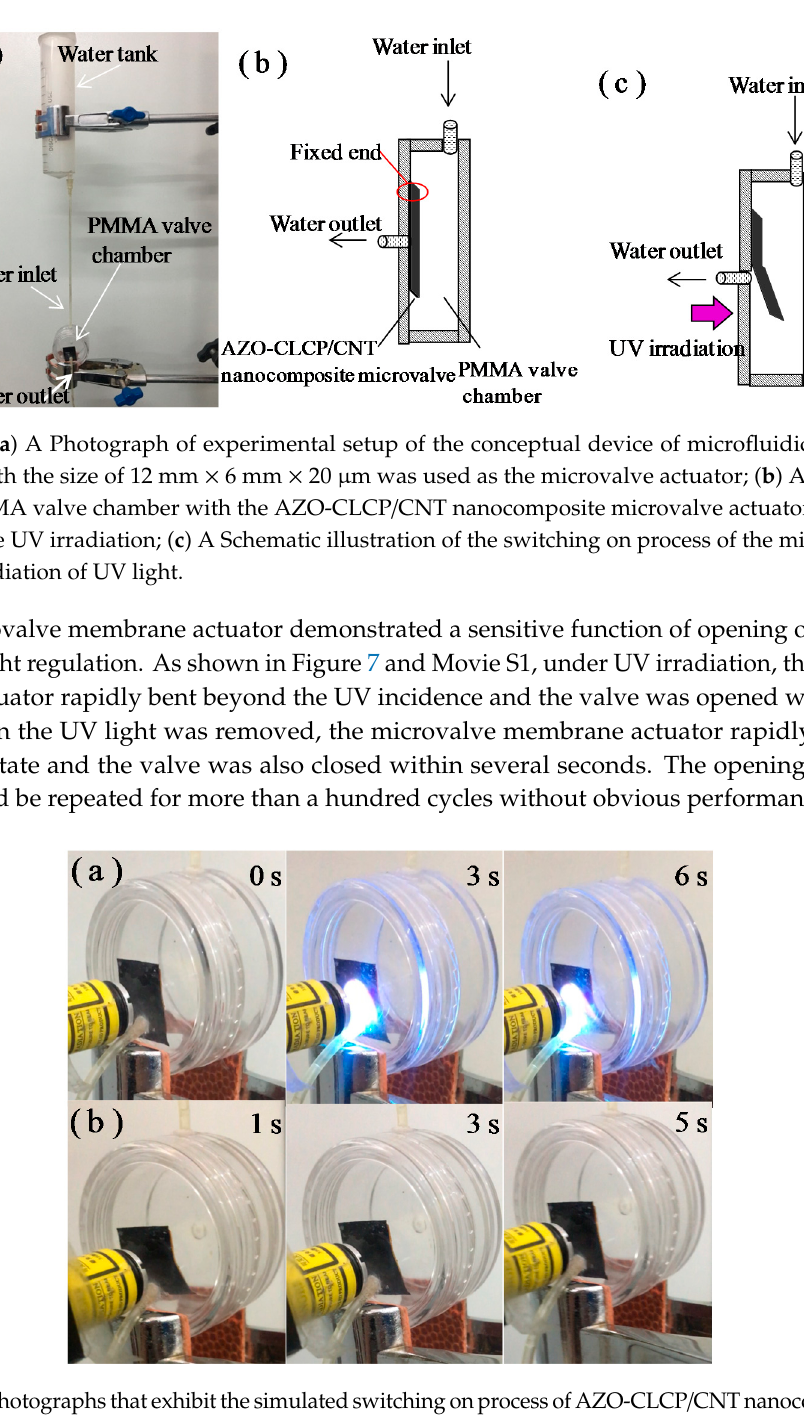
Figure 7. Photographs that exhibit the simulated switching on process of AZO-CLCP/CNT nanocomposite microvalve under irradiation of UV light ( a ) and switching off process of AZO-CLCP/CNT nanocomposite microvalve after the UV source was switched off ( b ). A CF20 with the size of 12 mm × 6 mm × 20 µm was used as microvalve actuator. The wavelength and intensity of the used UV light was 366 nm and 1.5 mW/cm 2 respective. The room lamplight was kept on consistently.